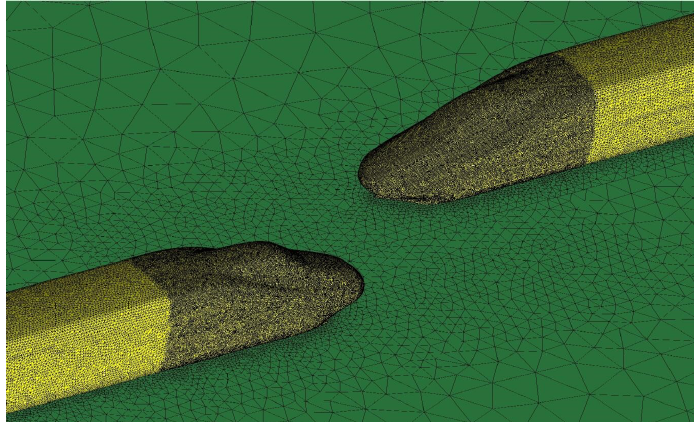
Fig. 5. Local mesh of type B train calculation